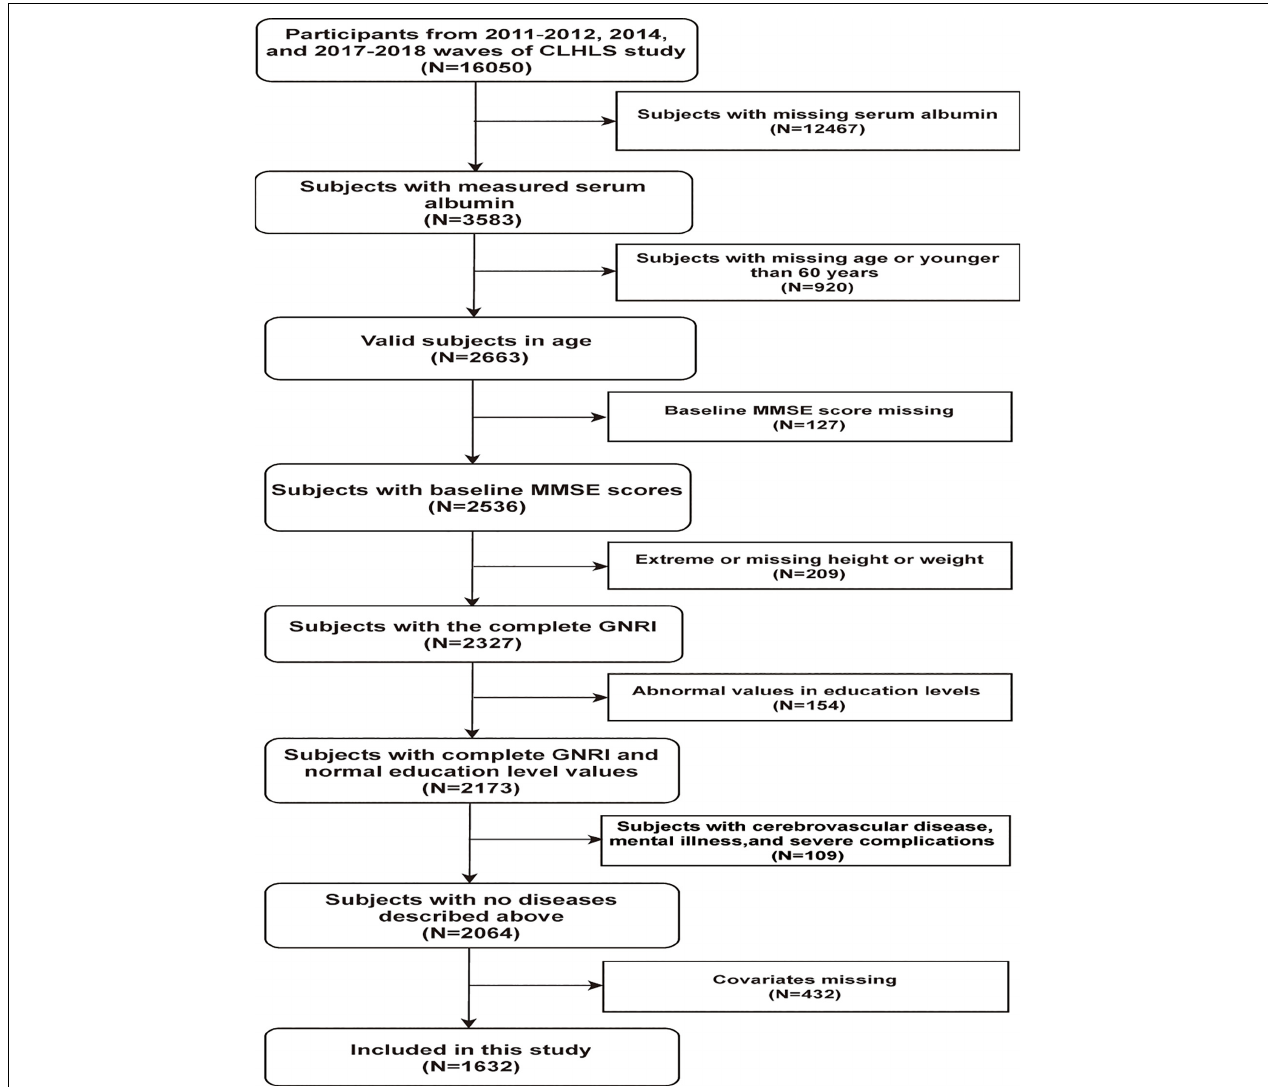
FIGURE 1 | Flowchart of the study